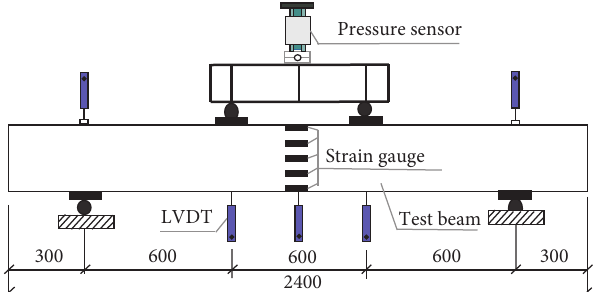
Figure 4: Instrumentation setup and load distribution (all di- mensions in mm).